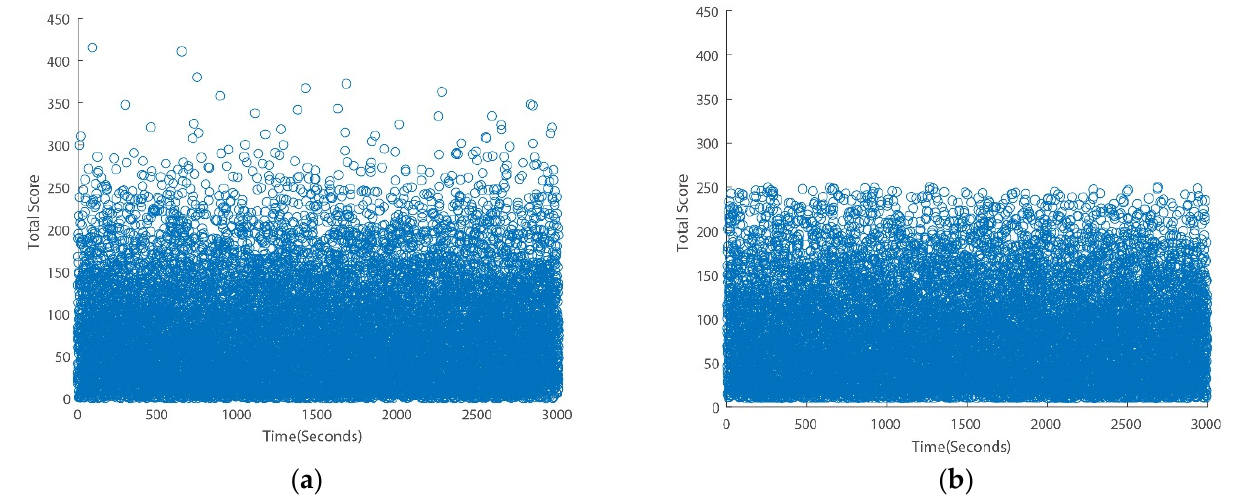
Figure 9. The total calculated score of analysis for a programing course ( a ) before Grubbs’s test and ( b ) after Grubbs’s test.